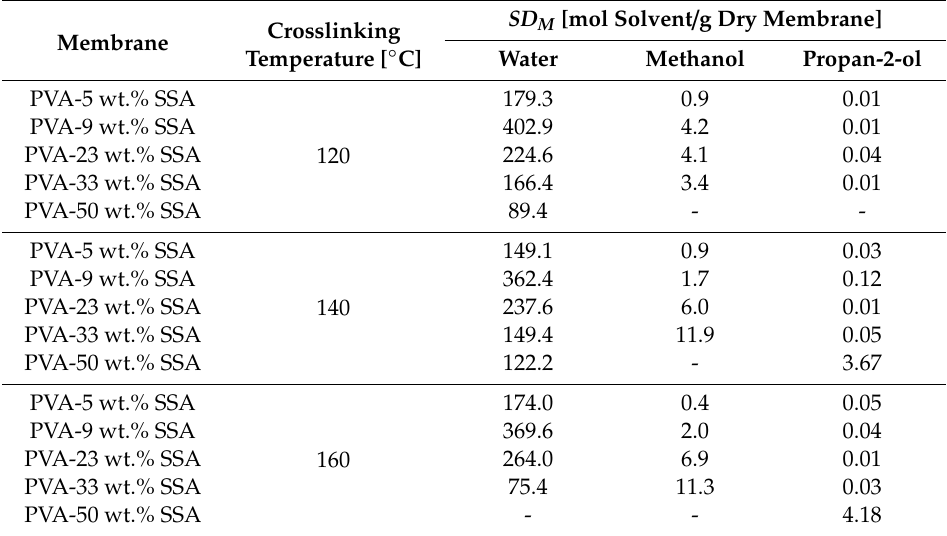
Table 4. The molar swelling degree SD M of the heat-treated PVA-SSA membranes in water, methanol and propan-2-ol as a function of the SSA concentration and crosslinking temperature. SD M [mol Solvent / g Dry Membrane] Crosslinking Membrane Temperature [ ◦ C] Water Methanol